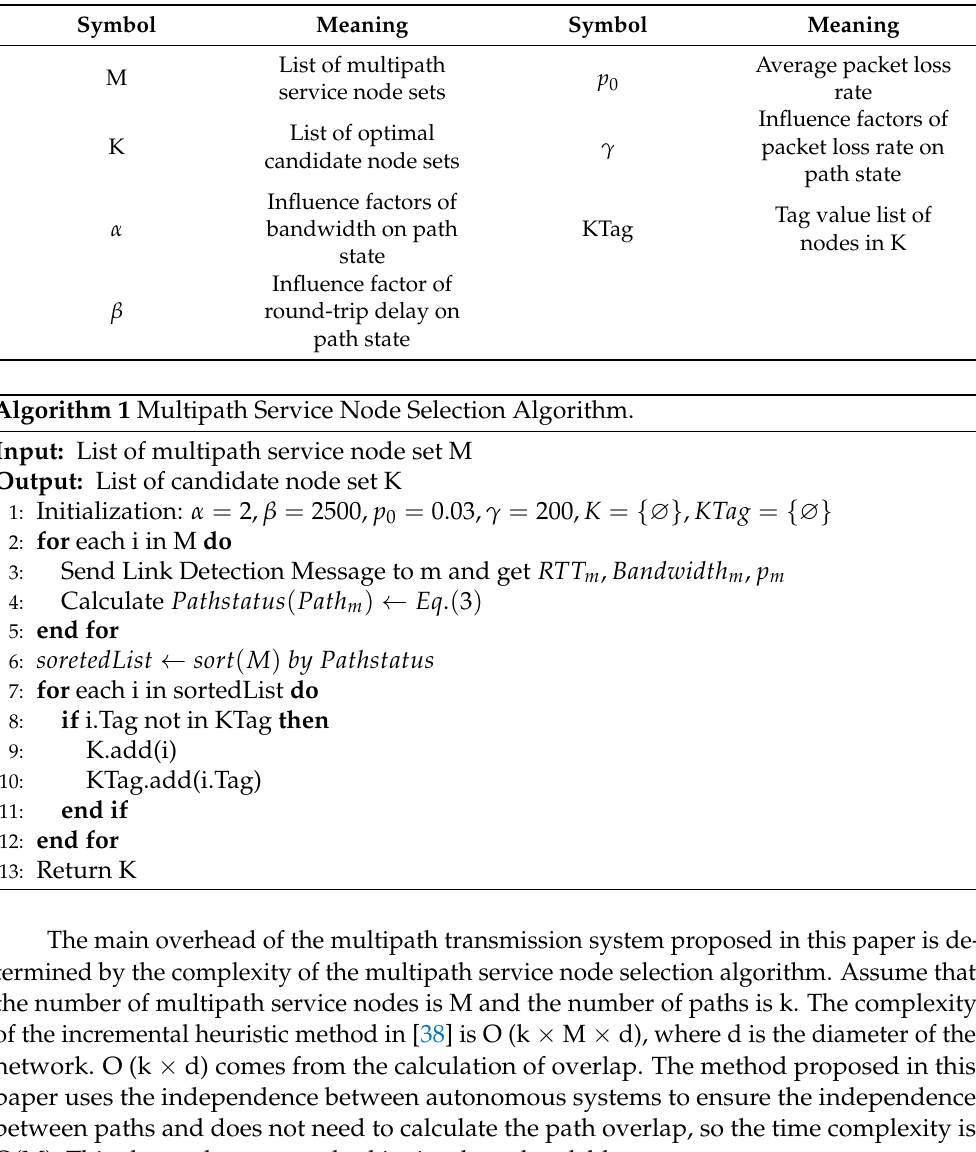
Table 1. The meaning of symbols.